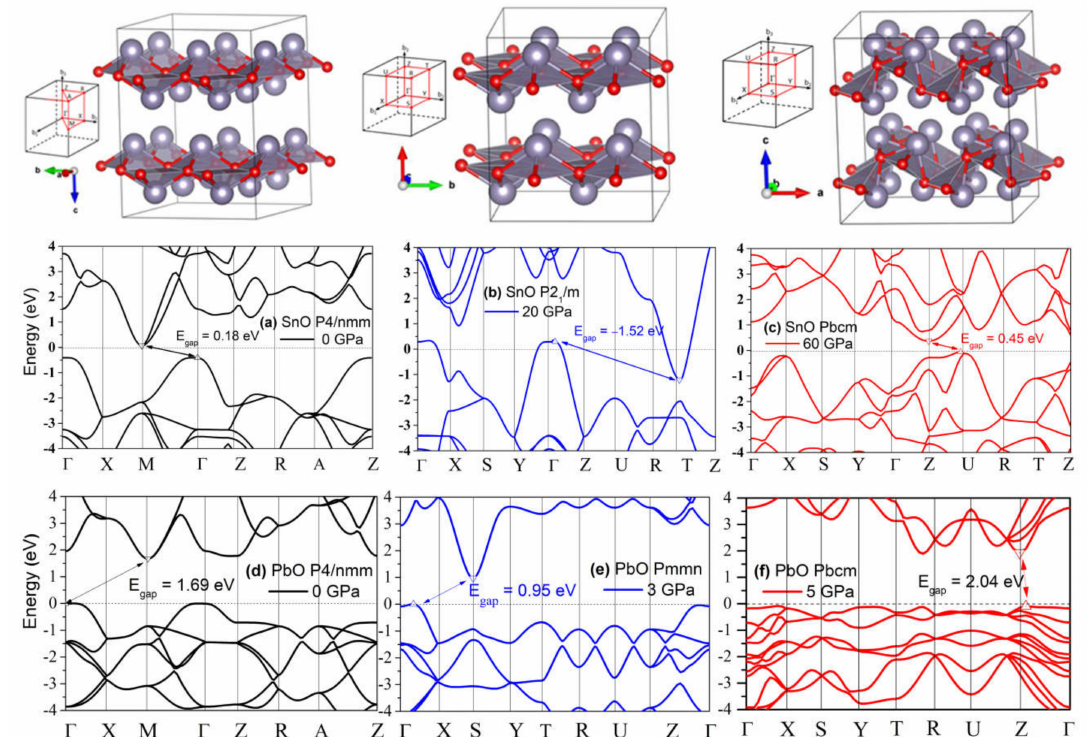
Figure 12. The polymorphs of layered SnO/PbO and their electronic band modification upon compression. The gaps between valence band maximum (VBM) and conduction band minimum (CBM) are marked by arrows and values. A negative gap value indicates an overlap of CBM and VBM due to the reduced distance between the two layers: ( a ) Band structure of P4/nmm SnO at 0 GPa; ( b ) Band structure of P2 1 /m SnO at 20 GPa; ( c ) Band structure of Pbcm SnO at 60 GPa; ( d ) Band structure of P4/nmm PbO at 0 GPa; ( e ) Band structure of Pmmn PbO at 3 GPa; ( f ) Band structure of Pbcm PbO at 5